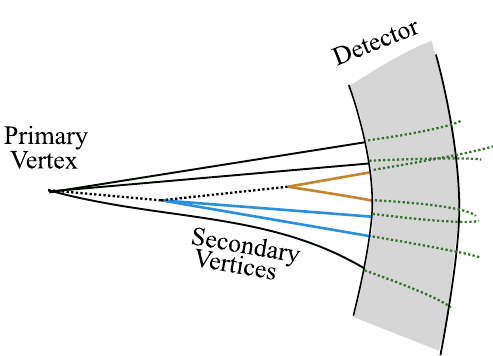
Fig. 1 Illustration of a jet with secondary decay vertices. In order to identifytheflavorofthejet,vertexreconstructionaimstogrouptogether the tracks measured in the detector based on their point of origin